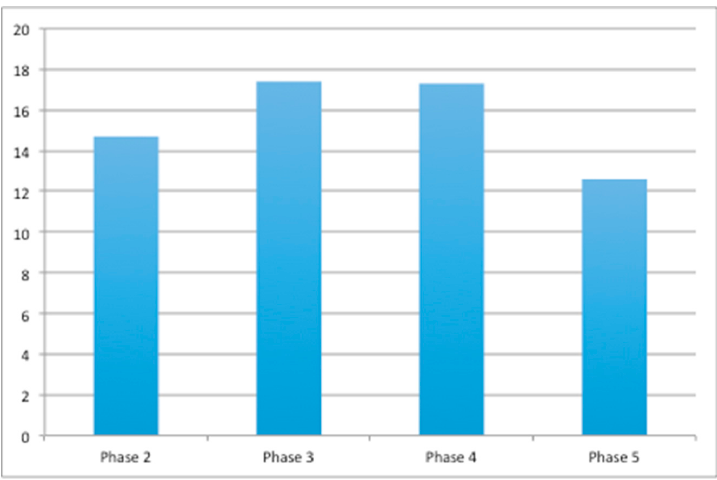
Figure 2. Average time (s) the dogs spent on each toy from phase 2 to 5.